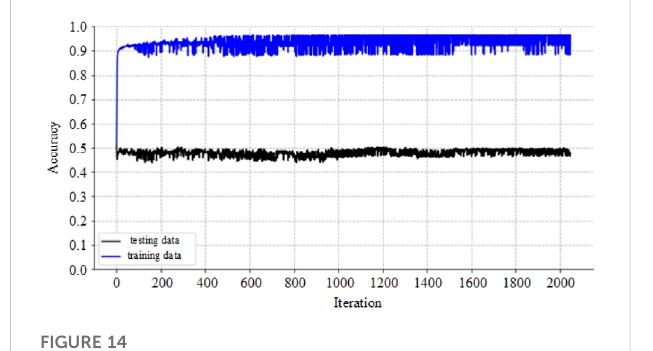
FIGURE 14 Accuracy of SAE-dropout network.